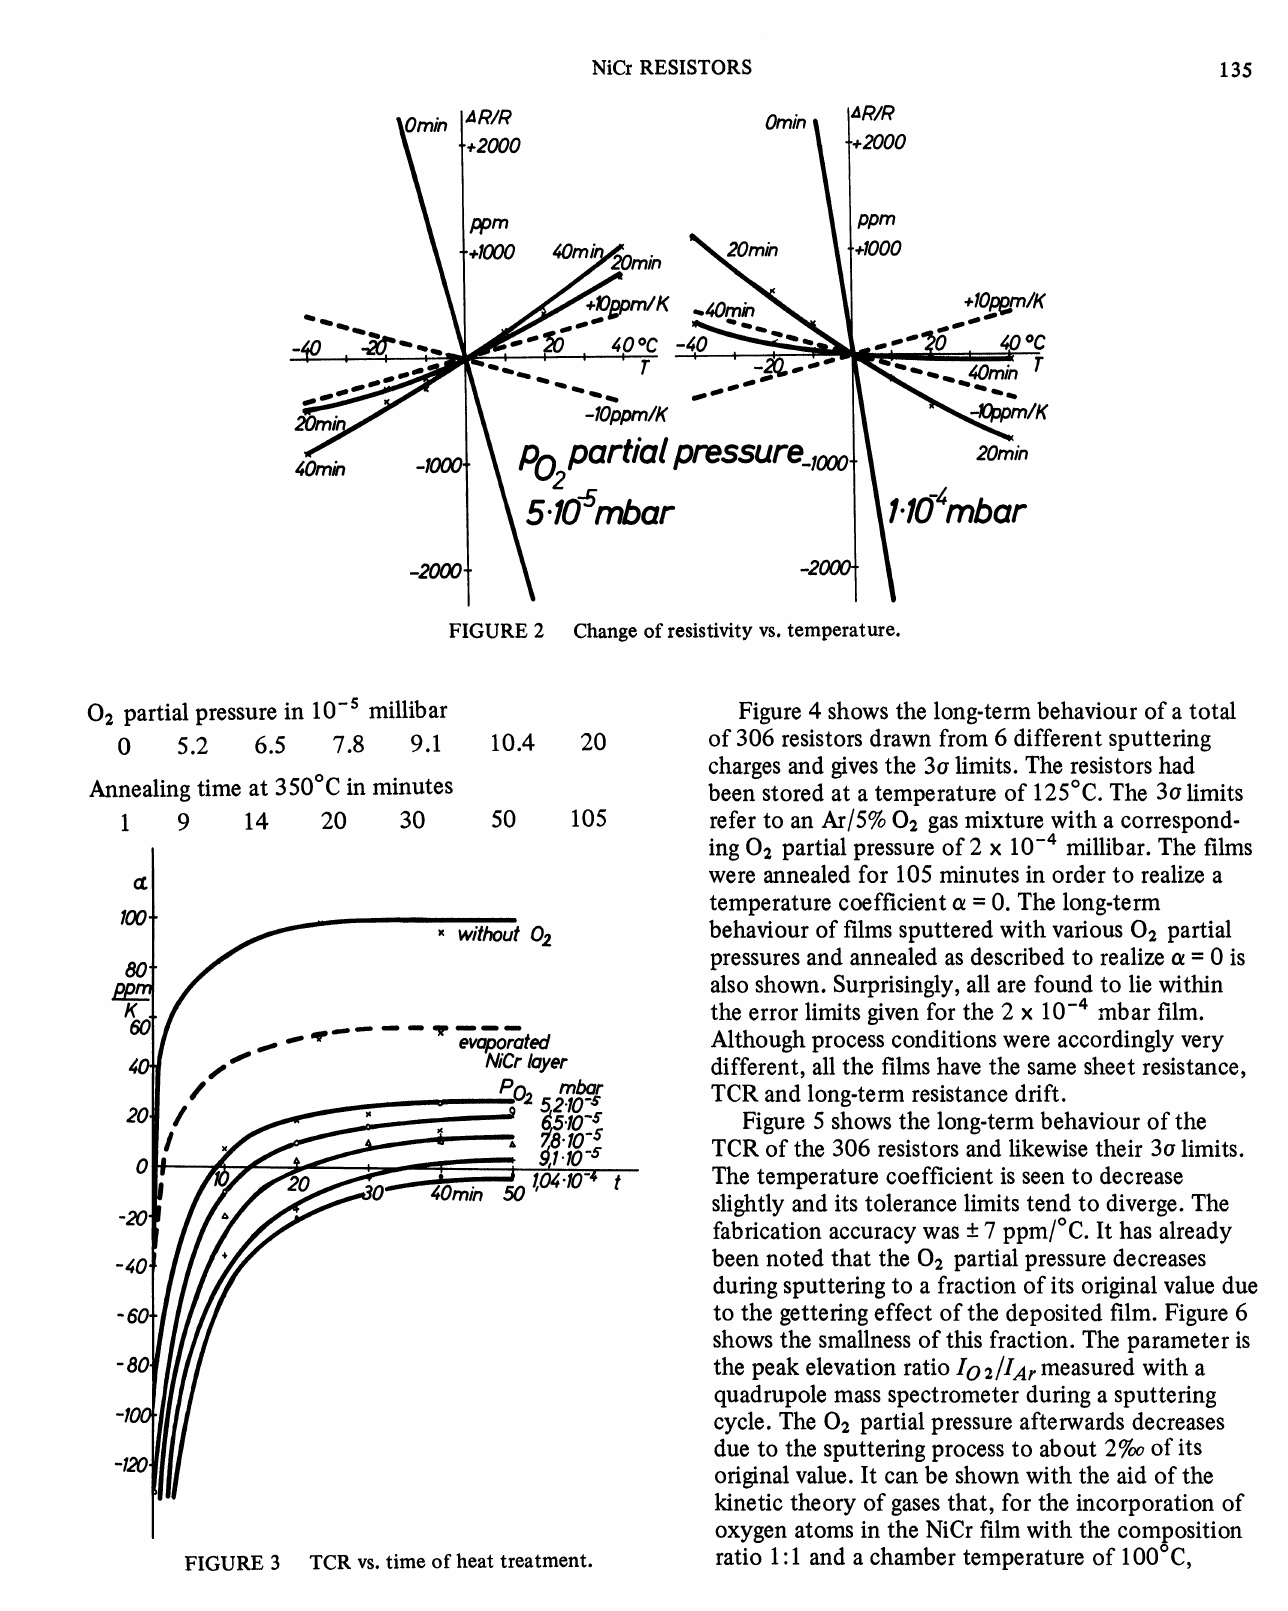
-lOppm/K pFessl.lr’eqooo. 20rain